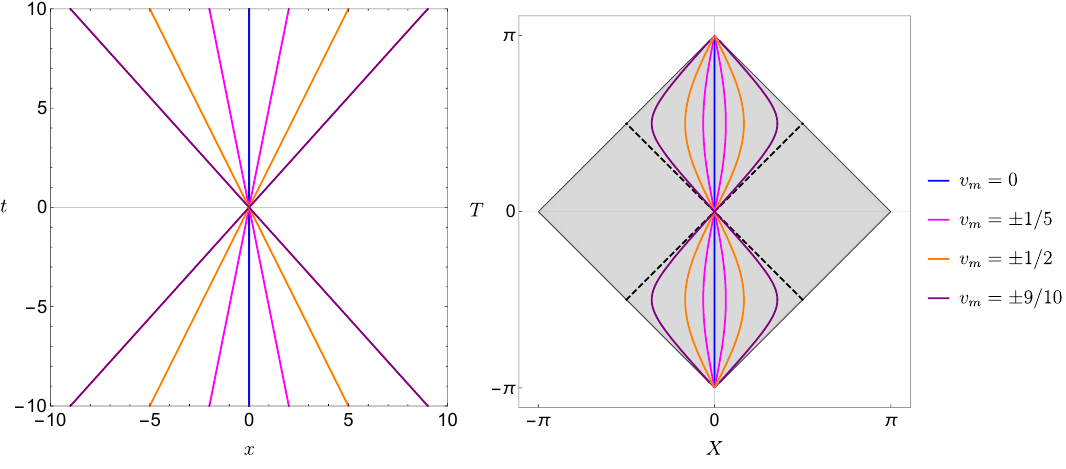
Figure 5 . Trajectories of type A mirrors with a constant velocity v m